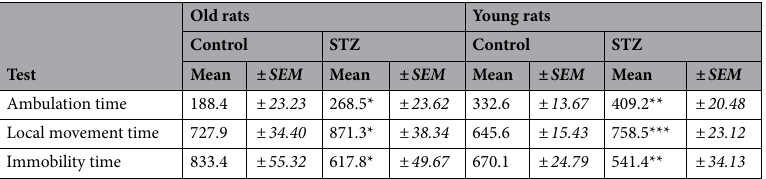
Table 2. Open field results of icv. STZ-injected (‘STZ’) and vehicle-treated (‘control’) rats. Columns include means ± SEM values. ‘Old rats’ column: *: p < 0.05 significant difference between groups, unpaired t-test,